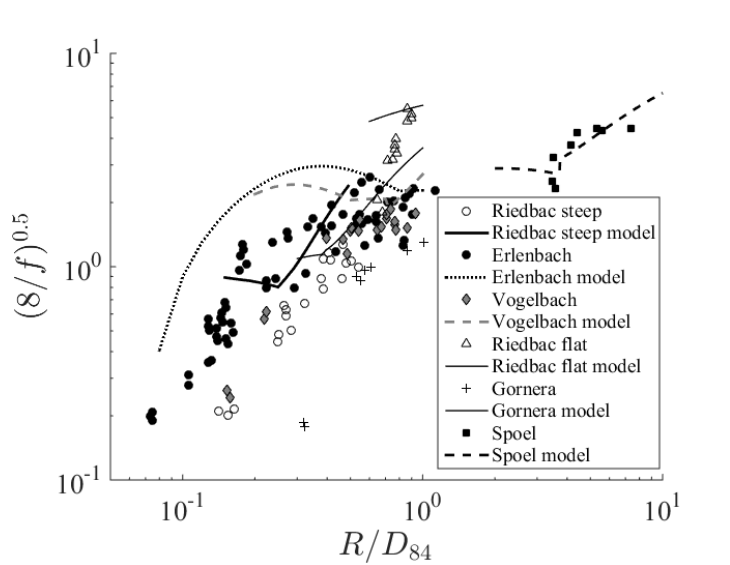
Figure 12. Hydraulic resistance of real boulders for steep slope rivers. Data from [19] for sites with different configuration, comparison with the present model.